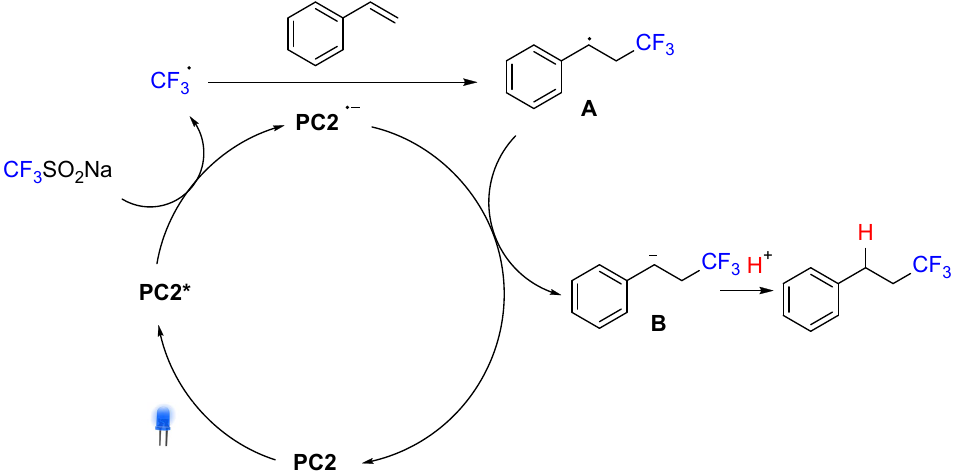
Figure 4. Proposed mechanism for the Hydrofluoroalkylation of styrenes developed by the group of Tlili.